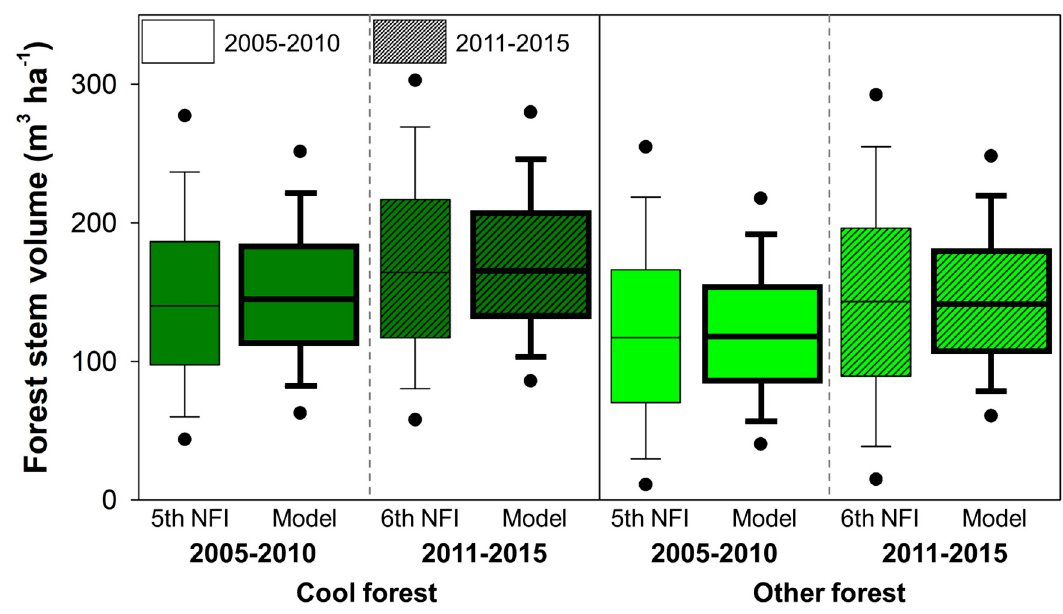
Figure 7. Distribution plots of estimated and observed forest stem volume (m 3 ha − 1 ) for Cool forests and other forests. The fifth and the sixth National Forest Inventory data corresponded to the estimated mean values in 2005–2010 and 2011–2015. For each box plot, the top circle is the 95th percentile, the lower circle is the fifth percentile, the top bar is the 90th percentile, the lower bar is the 10th percentile, the top of the box is the upper or the third quartile, the bottom of the box is the lower or the first quartile, and the middle bar is the median value.